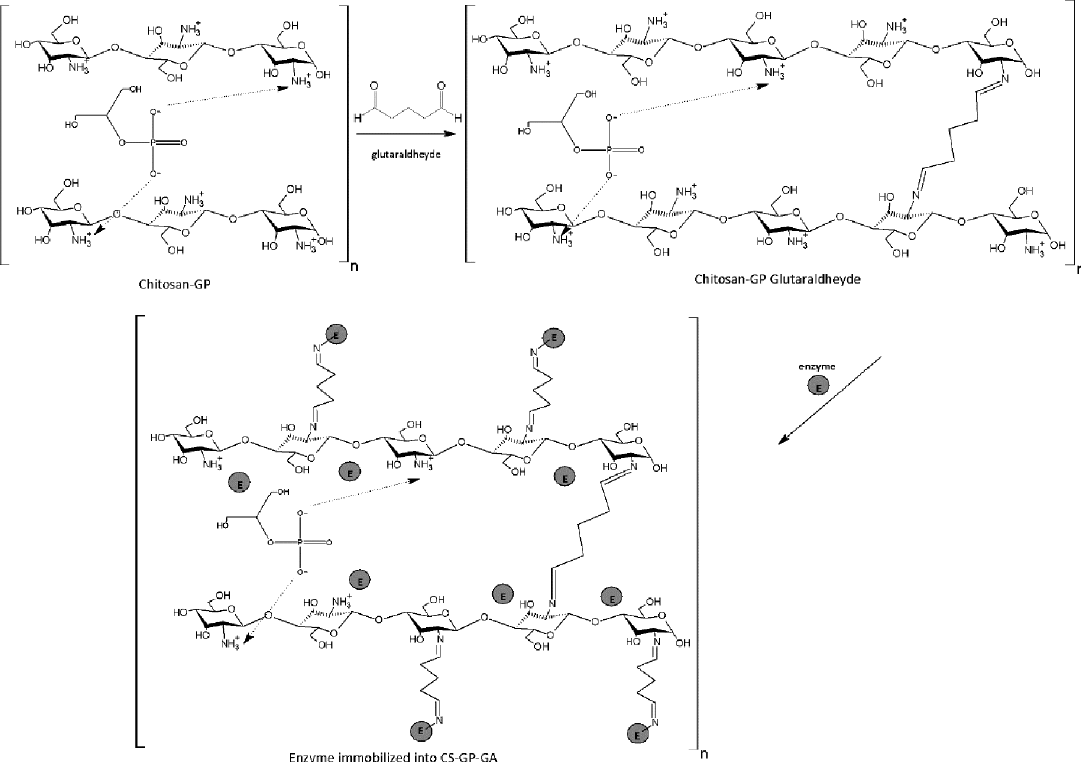
Figure 2. Hypotetic representation of CS-GP matrix formation and and lipase immobilization by covallent